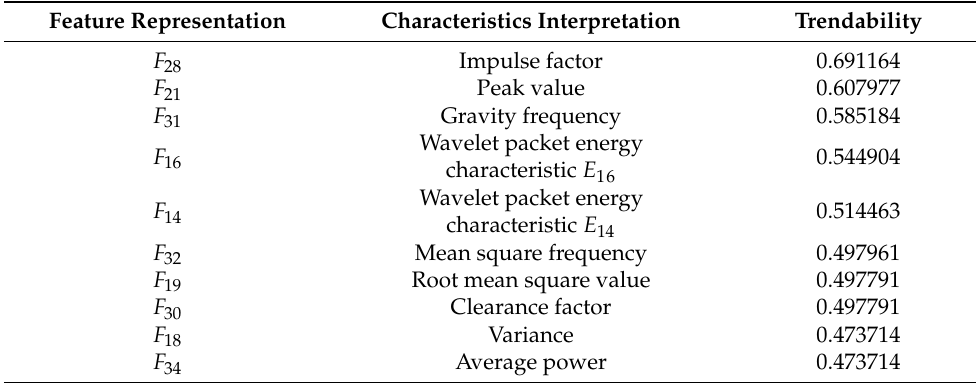
Figure 11. The trendability parameters of each characteristic of gear pumps. Table 4. The characteristics after selection and their trendability.